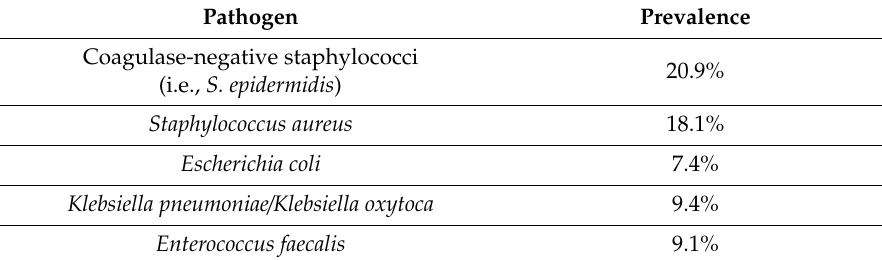
Table 2. Catheter related blood stream infection (CRBSI) associated pathogens